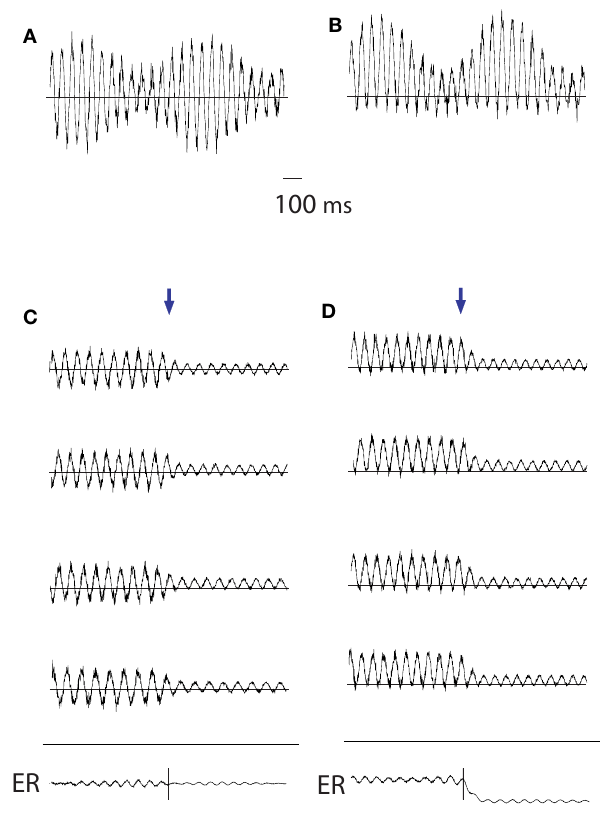
Figure 1 | The concept of “amplitude asymmetry.” (A) The amplitude modulation of neuronal oscillatory activity is conventionally viewed as being symmetric around zero. (B) We propose that the amplitude modulations of the oscillatory activity are asymmetric such that the peaks are more strongly modulated than the troughs. For the 10-Hz alpha activity, this could be explained by bouts of activity every ∼ 100 ms. (C) The conventional view ignoring asymmetric modulations of oscillatory activity would mean that averaging across trials (the arrow representing the start of the evoked response) would not result in the generation of slow fields. (D) As a direct consequence of amplitude asymmetry, a depression (or increase) in alpha activity in response to a stimulus will result in the generation of slow fields when multiple trials are averaged. Adapted from Mazaheri and Jensen (2008).